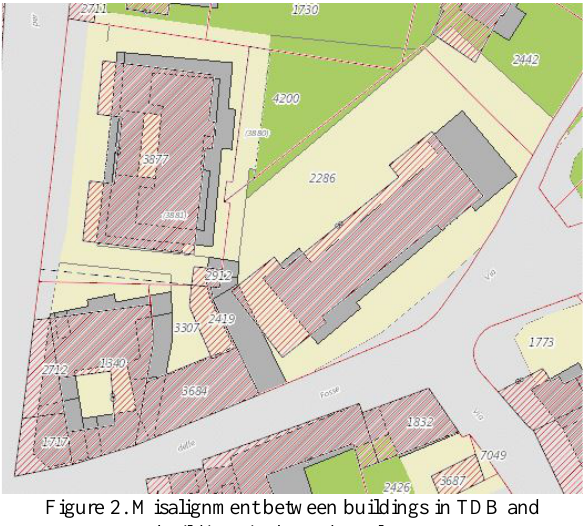
Figure 2. Misalignment between buildings in TDB and buildings in the cadastral